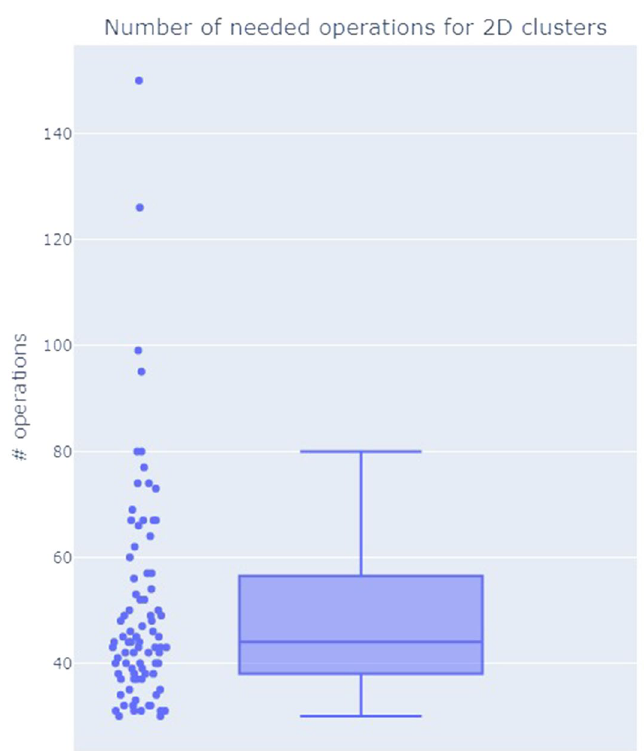
Fig. 6 Distribution of the convergence time in terms of the number of operations in the 2-D clustering